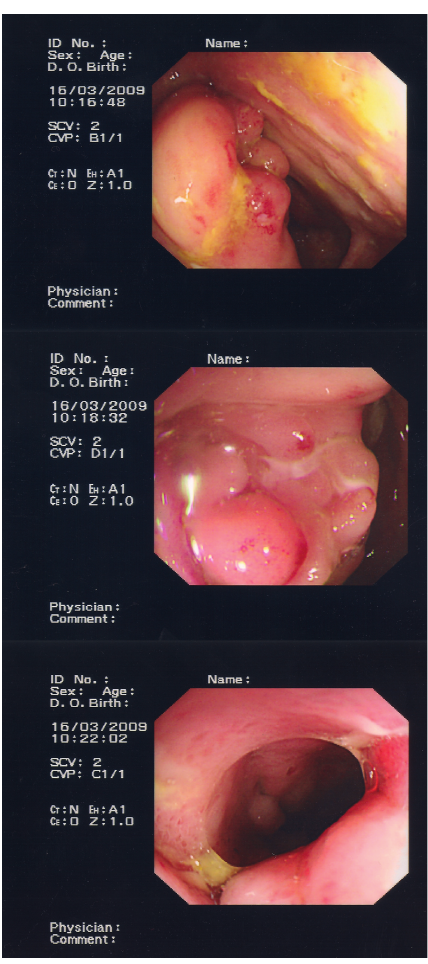
Figure 2: Colonoscopy images. Top: ilealcaecal valve ulceration, bottom: terminal ileum